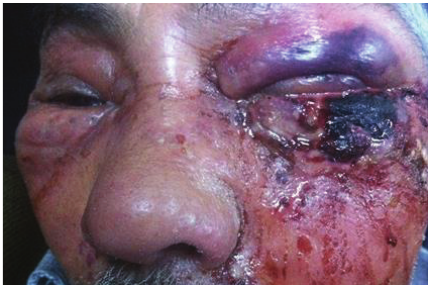
Figure 1: Anterior view of the patient at the emergency clinic.